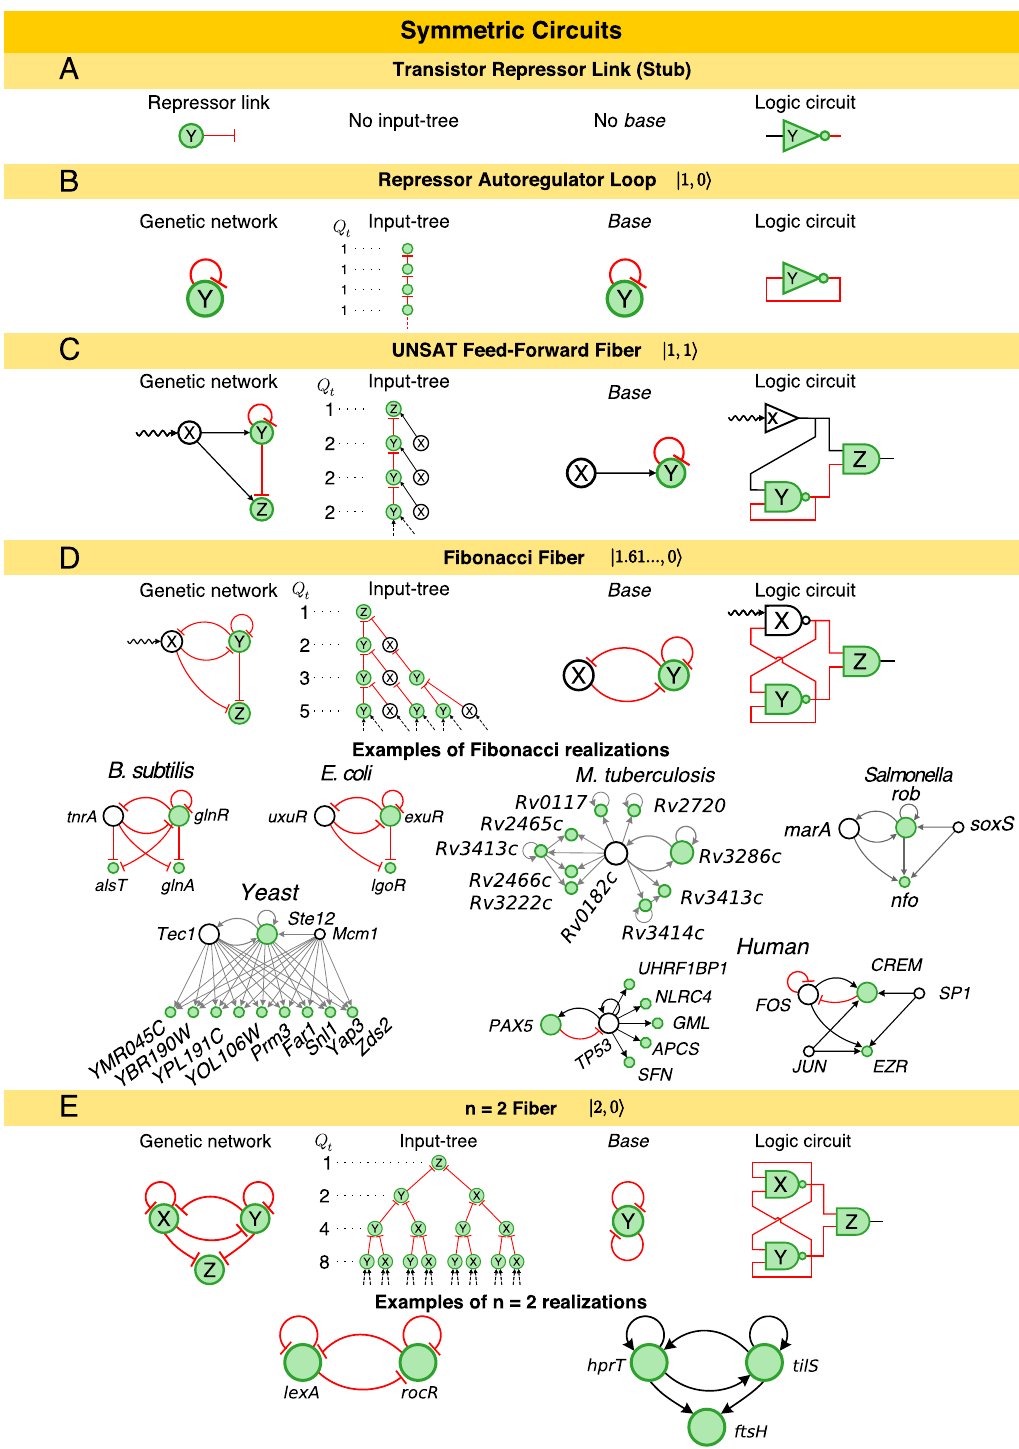
PLOS Computational Biology | https://doi.org/10.1371/journal.pcbi.1007776 June 17,